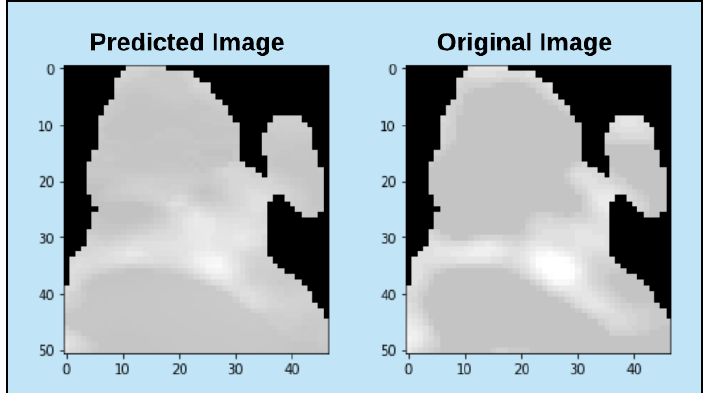
Figure 9. Example of an image prediction made with the model